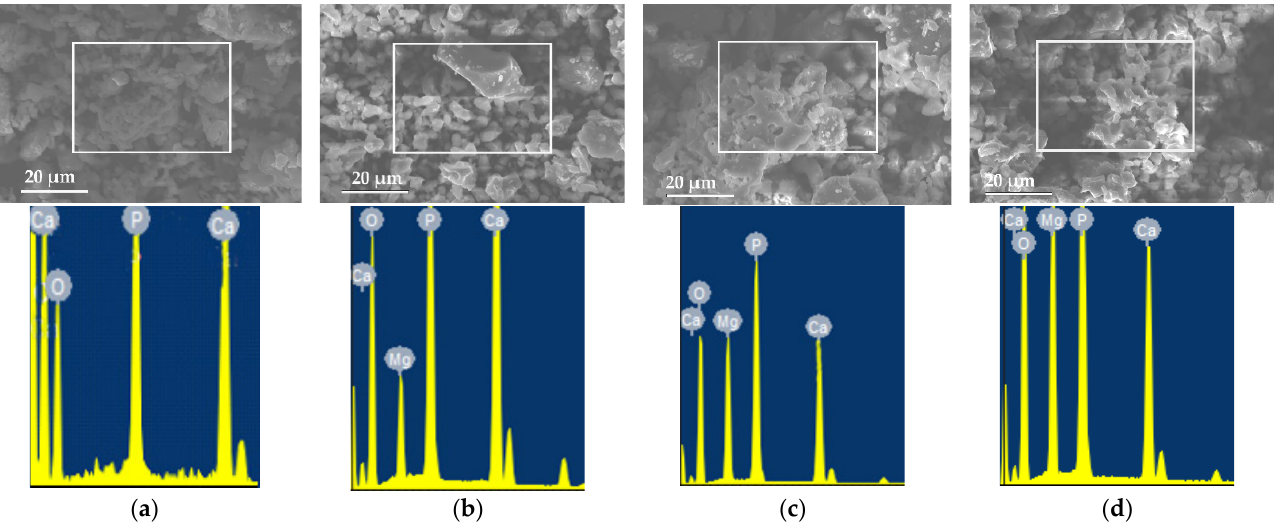
Figure 2. Micrographs and corresponding tested area and EDS spectra of Mg x Ca 3 − x (PO 4 ) 2 powders for the production of ceramics compositions: ( a ) Mg0; ( b ) Mg0.75; ( c ) Mg1.5; ( d ) Mg2.25. Magnification × 3000. Table 3. EDS results for the selected area of Figure 2.